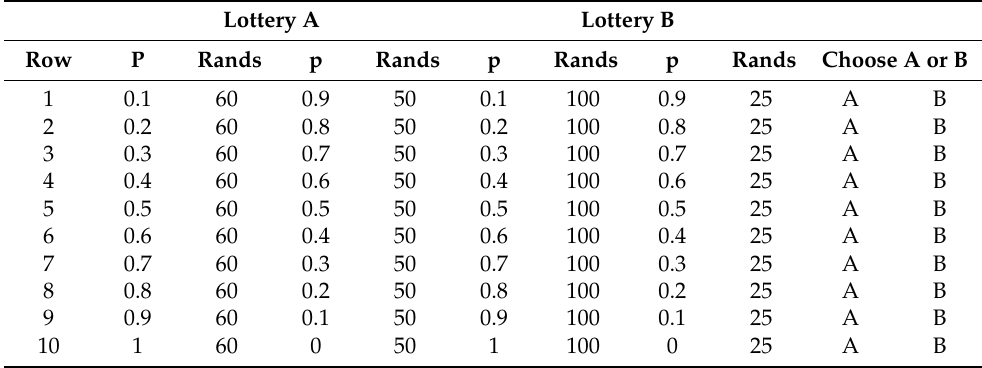
Table 1. Typical payoff matrix for the risk preference experiments—task